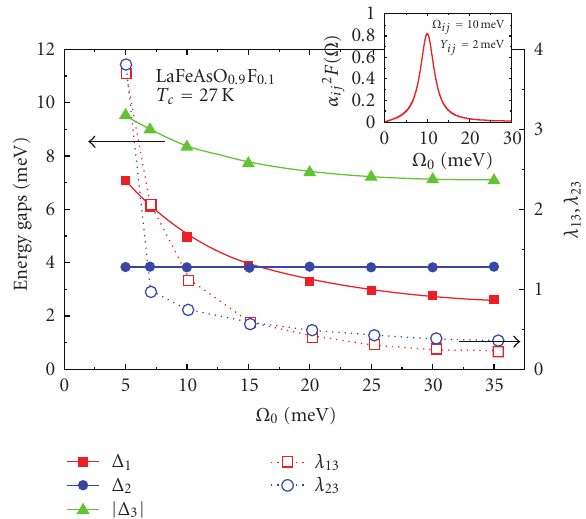
Figure 2: Full symbols, left axis: calculated gap values at T = 2 K for LaFeAsO 0 . 9 F 0 . 1 as a function of typical boson energy Ω 0 . Open symbols, right axis: electron-boson coupling constants, λ 13 and λ 23 , as a function of Ω 0 . The inset shows the spectral function used in this model in the case Ω ij = 10